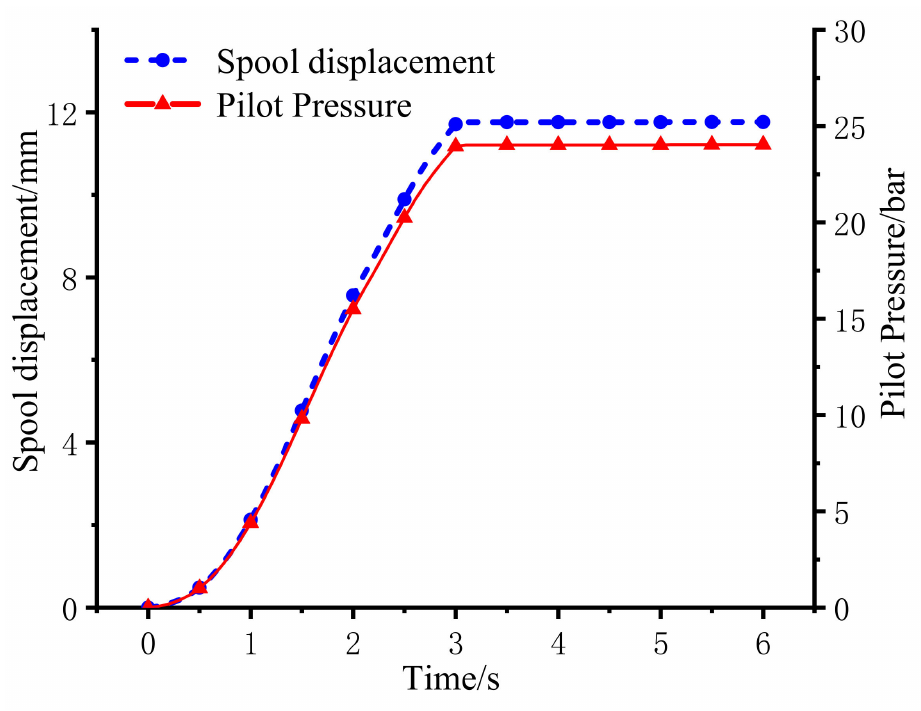
Figure 8. Relationship between the pilot pressure and spool